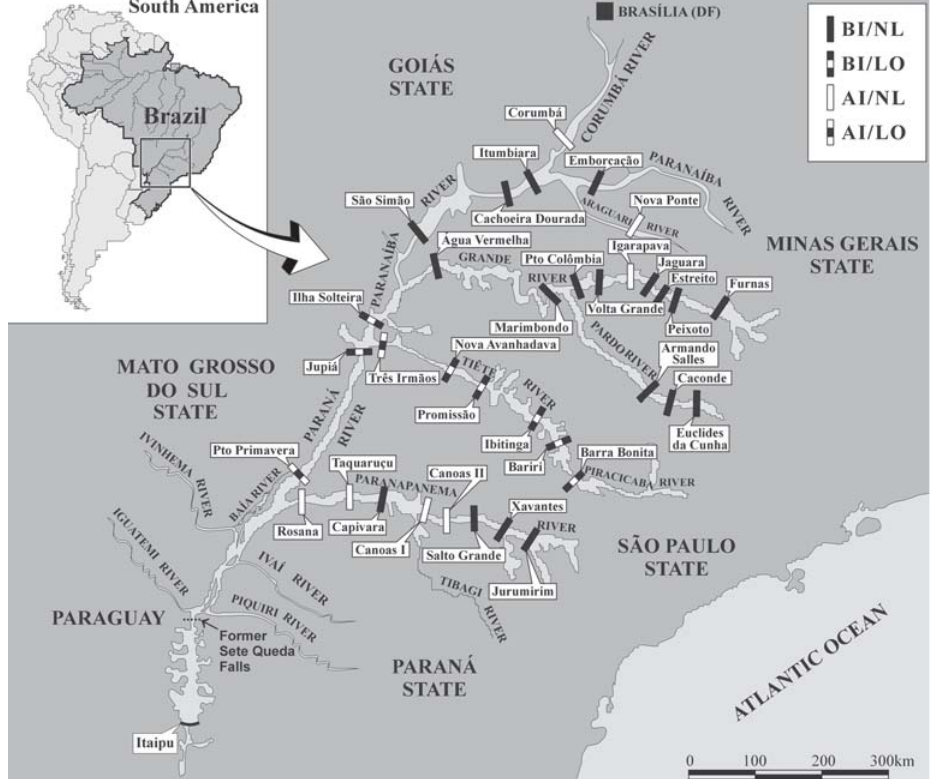
Fig. 1. Location of the former Sete Quedas falls barrier (which used to separate two ichthyofaunistic provinces) and main dams of the upper Paraná River basin (BI/ = closed before Itaipu dam closure; AI/ = closed after Itaipu dam closure; /NL = no lock; /LO =